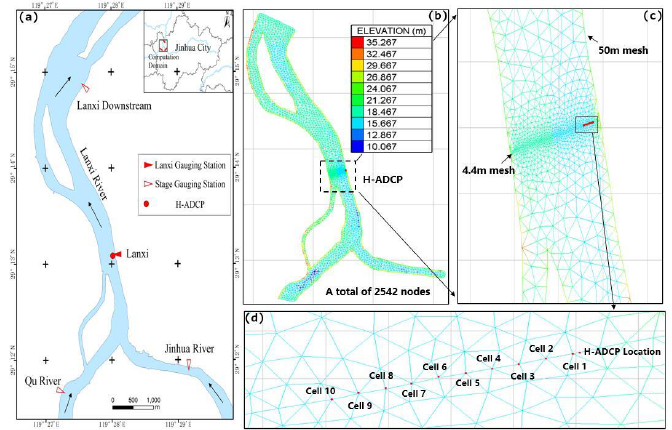
Figure 3. ( a ) Map of Lanxi River; ( b ) a 2D computation mesh of the considered experiment reach; ( c ) the 10 cell locations of HADCP and mesh size of the considered experiment reach; ( d ) details of the 10 cell locations of